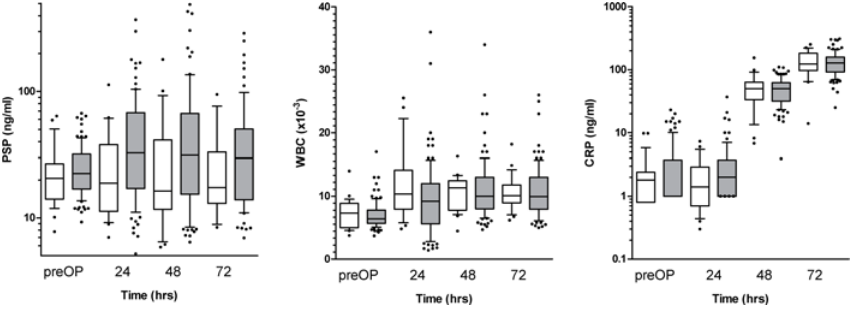
Fig 4. Time course of biomarkers as related to the absence or presence of cardiopulmonary bypass. All inflammatory markers investigated showed a steeper rise in patients subjected to cardiopulmonary bypass without reaching statistical significance. (p > 0.05 for interaction for all biomarkers, determined by a linear mixed effects regression